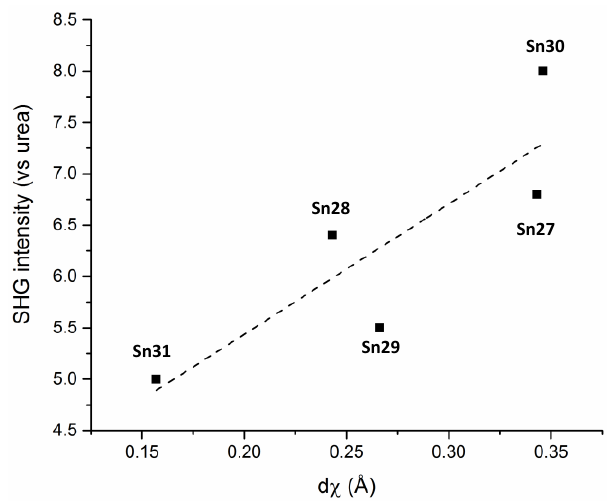
Figure 43. SHG intensities as a function of the degree of chirality (dχ).